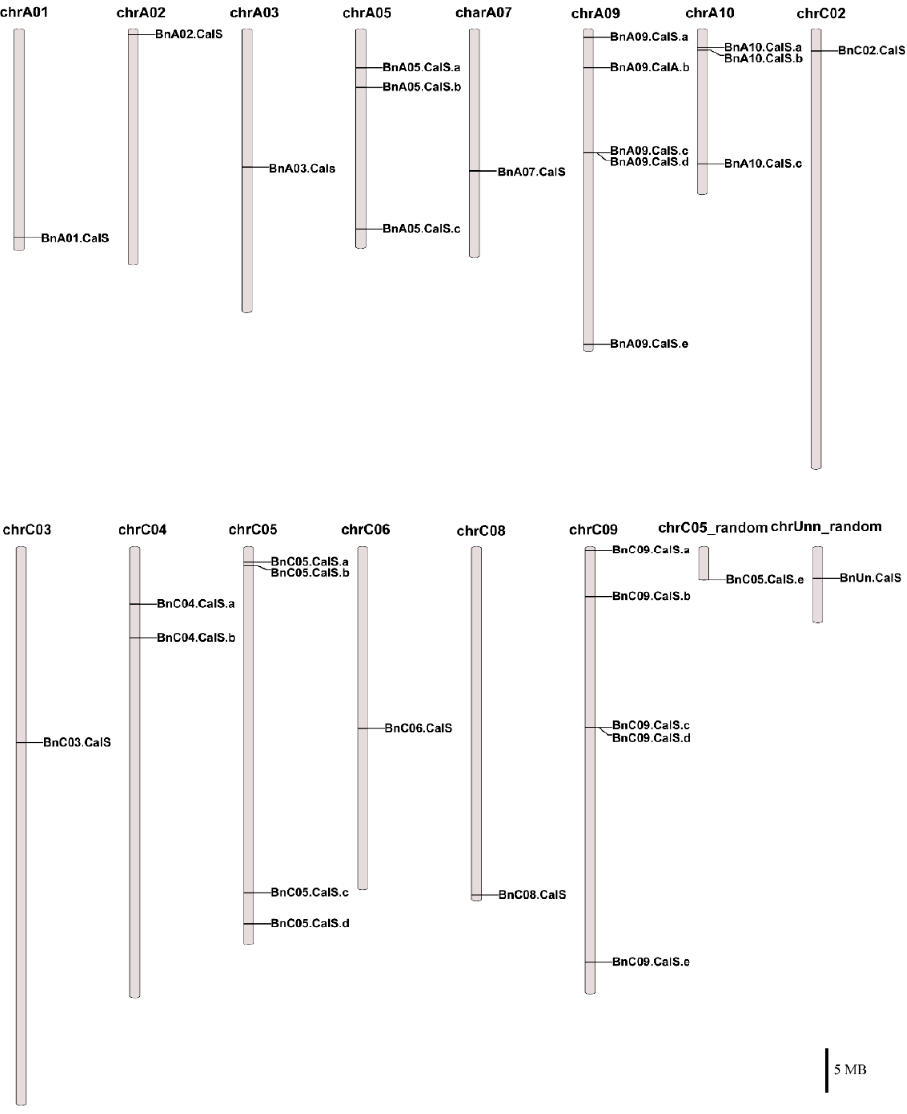
Figure 3. Chromosomal locations of 32 BnCalS genes. The chromosome number is placed above each chromosome. Only those chromosomes containing BnCalS genes (15) are listed. Scale bar represents a 5 Mb physical distance.